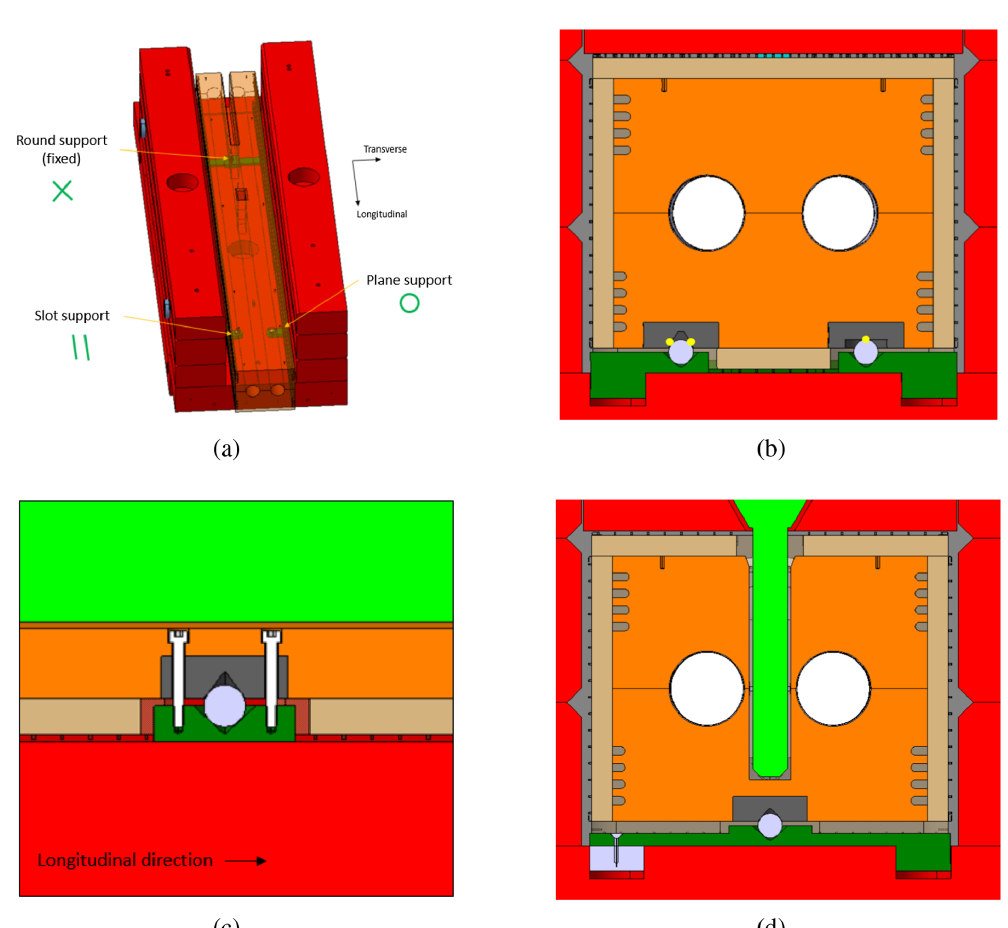
FIG. 5. Absorber support description. (a) General scheme of the absorber supports conguration. (b) Slot and plane supports (transverse cross section). (c) Round support (longitudinal cross section) (d) Round support (transverse cross